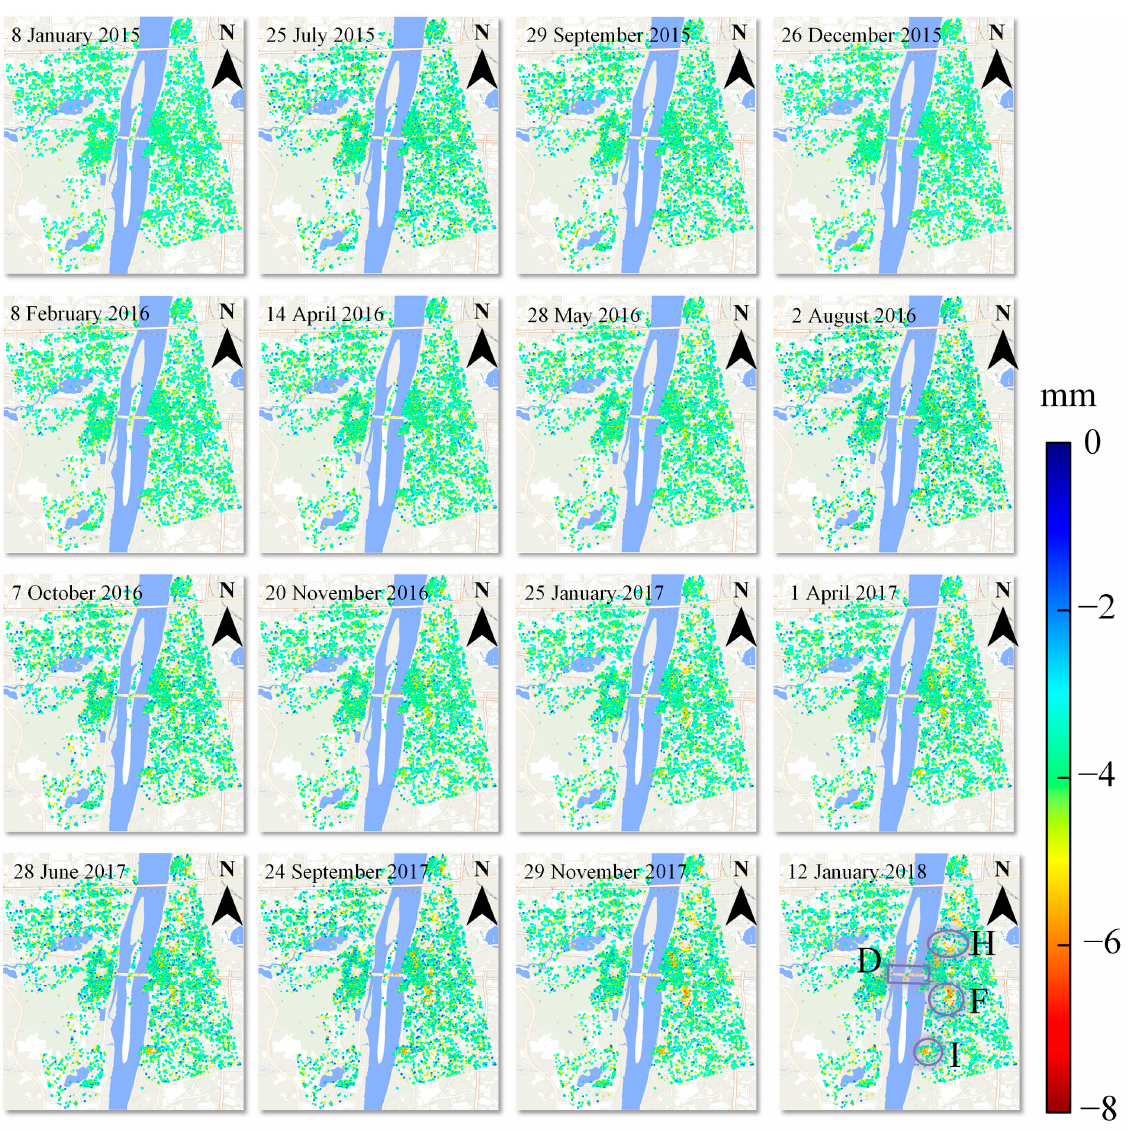
Figure 9. Time-series deformation of the study area (D represents the Orange Island Bridge; F represents the area near International Finance Square building; H represents the area near Zhongshan Pavilion; I represents the area near Poly International Plaza).